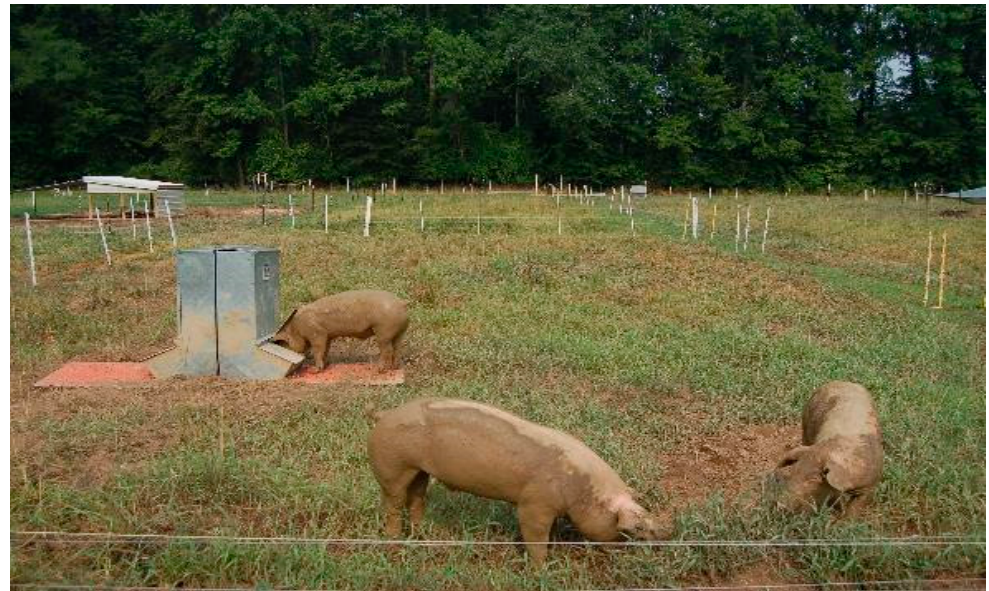
Figure 4. View of a rotationally stocked paddock during the second grazing period (May to August). In front, pigs in the grazing sections. Back left, the service-central section with the shelter and the drinking station.